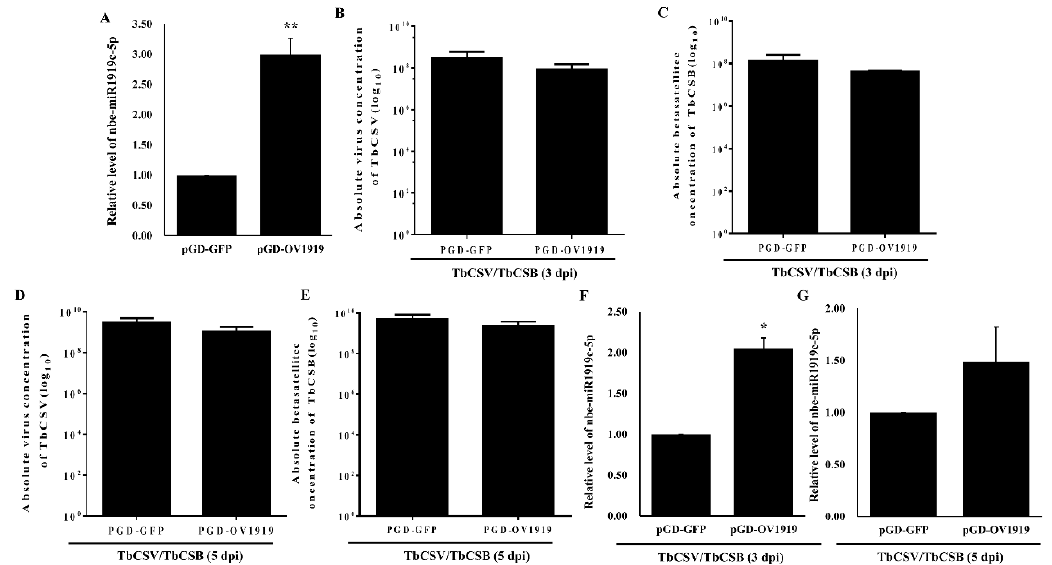
Figure 4. The accumulations of TbCSV and TbCSB DNAs in the N. benthamiana leaves transiently over-expressed nbe-miR1919c-5p. ( A ) Result of qRT-PCR showed that the expression of nbe- miR1919c-5p in the pGD-OV1919-inoculated plants was significantly increased compared with the control plants (pGD-GFP). ( B ) Detection of TbCSV DNA copy number in the inoculated leaves harvested from the pGD-OV1919+TbCSV/TbCSB-inoculated or the pGD-GFP+TbCSV/TbCSB- inoculated plants at 3 dpi. ( C ) Detection of TbCSB DNA copy number in the inoculated leaves harvested from the pGD-OV1919+TbCSV/TbCSB-inoculated or the pGD-GFP+TbCSV/TbCSB- inoculated plants at 3 dpi. ( D ) Detection of TbCSV DNA copy number in the inoculated leaves harvested from the pGD-OV1919+TbCSV/TbCSB-inoculated or the pGD-GFP+TbCSV/TbCSB- inoculated plants at 5 dpi. ( E ) Detection of TbCSB DNA copy number in the inoculated leaves harvested from the pGD-OV1919+TbCSV/TbCSB-inoculated or the pGD-GFP+TbCSV/TbCSB- inoculated plants at 5 dpi. ( F ) Results of qRT-PCR showed that the expression of nbe-miR1919c-5p in the pGD-OV1919+TbCSV/TbCSB-inoculated plants was significantly increased compared with that in pGD-GFP+TbCSV/TbCSB-inoculated plants at 3 dpi. ( G ) Results of qRT-PCR showed that the expression of nbe-miR1919c-5p in the pGD-OV1919+TbCSV/TbCSB-inoculated plants was increased compared with that in pGD-GFP+TbCSV/TbCSB-inoculated plants at 5 dpi. *, P < 0.05; **, P < 0.01; determined by the Student’s t -test.